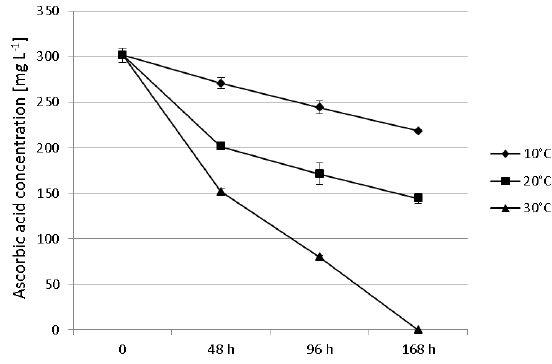
Figure 4: Changes in the concentration of ascorbic acid during storage of orange juice.